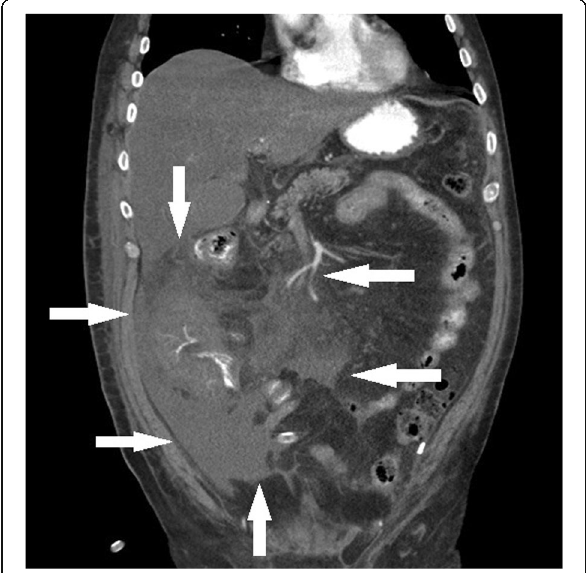
Fig. 1 CT scan showing an infiltrate in mesocolon ascendens invading radix mesenterii and the mesenteric